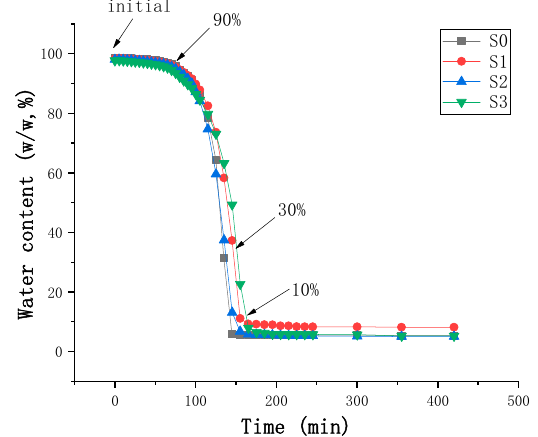
Figure 1. The drying kinetics curves of S0–S3 film-forming